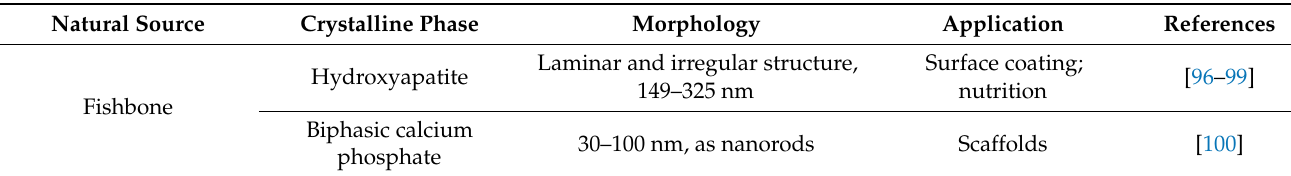
Table 3. Examples of CaPs obtained from natural